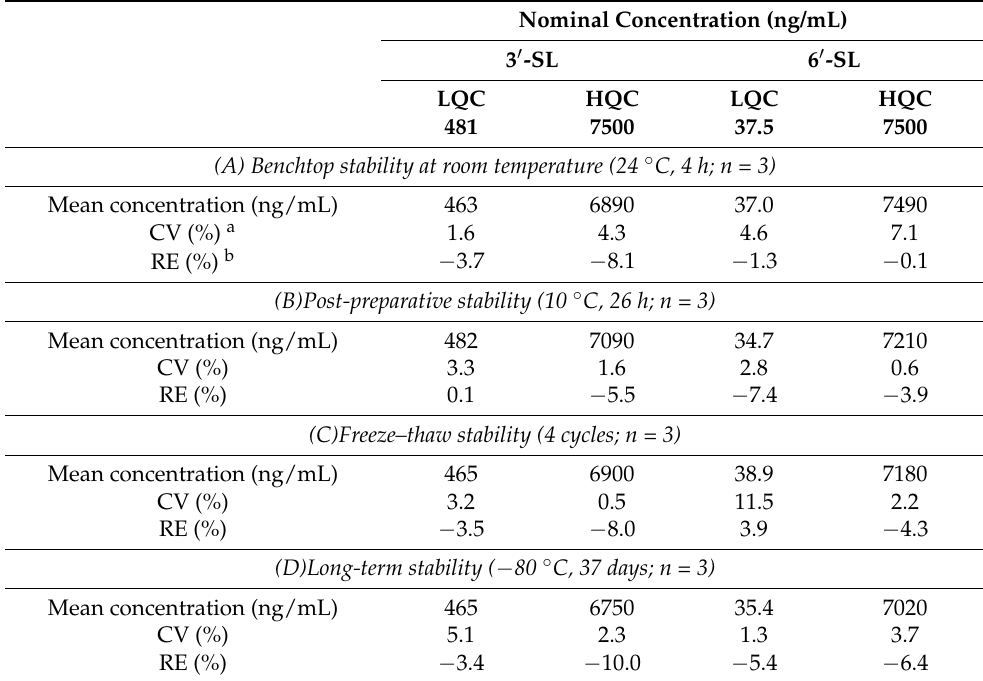
Table 5. Stability of biological samples.